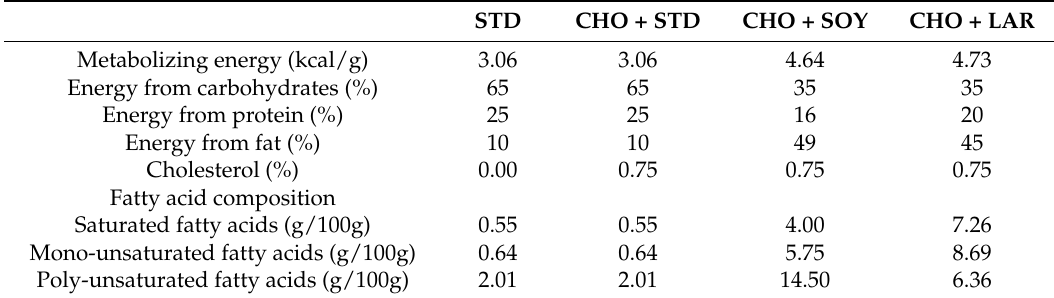
Table 1. Diet composition. Mice diets used in the feeding experiment. Standard chow diet (STD), 0.75% cholesterol in a Standard diet (CHO + CHO), 0.75% cholesterol in a high fat diet containing ω 6-PUFA-rich soybean oil (CHO + SOY), 0.75% cholesterol in a high fat diet containing mainly lard as fat source (CHO +